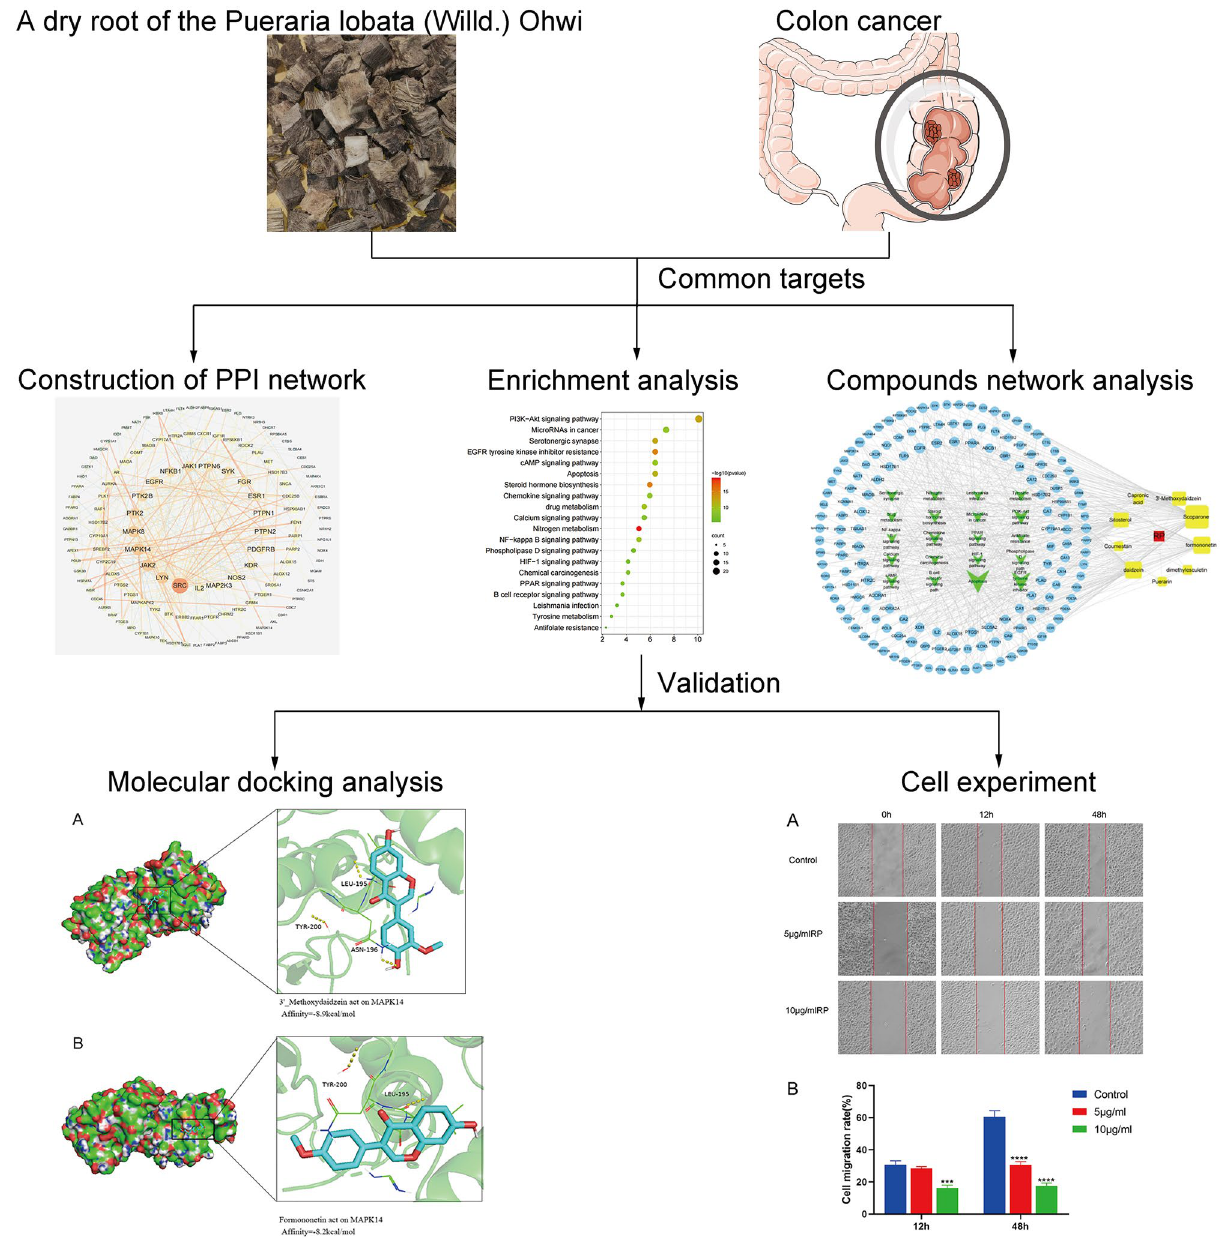
Figure 1. Flow chart for network pharmacology analysis and validation of RP anti-CC.